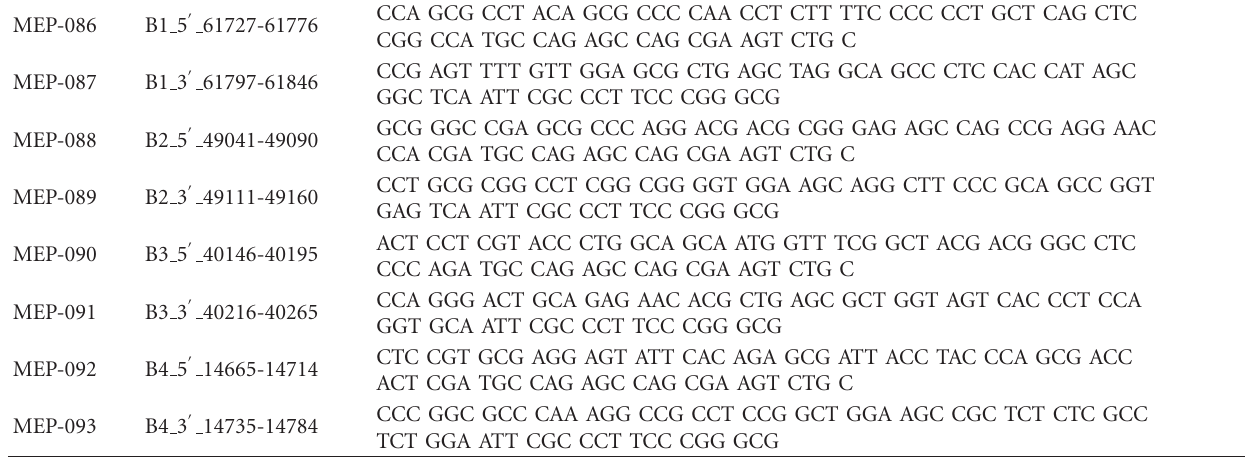
Table 3: Primers used for generating recombineering targeting fragments (Sections 3.4 and 3.6).